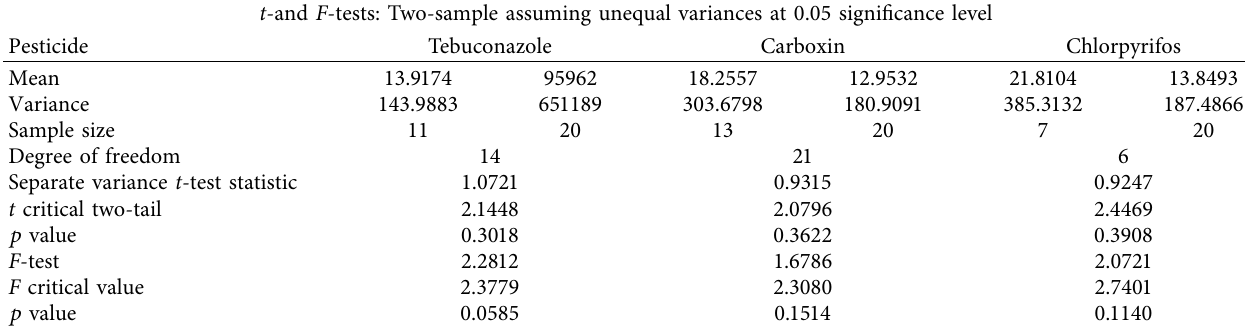
Table 8: Presence of other